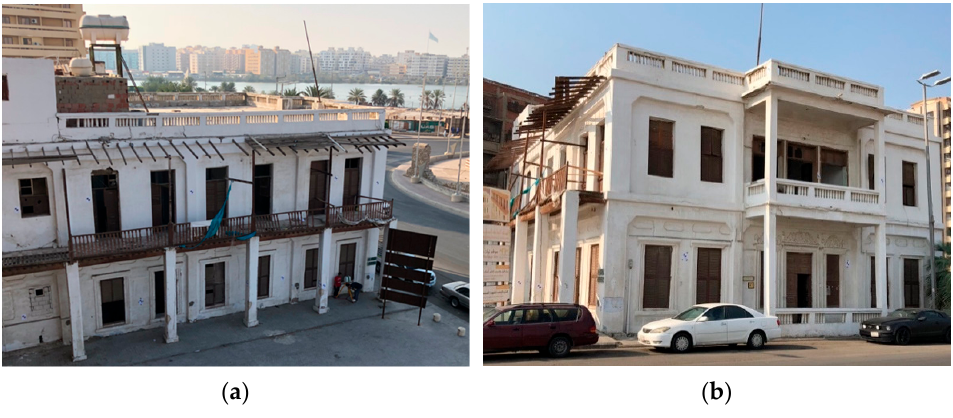
Figure 7. Bayt Zainal from the ( a ) east side and ( b ) north side.